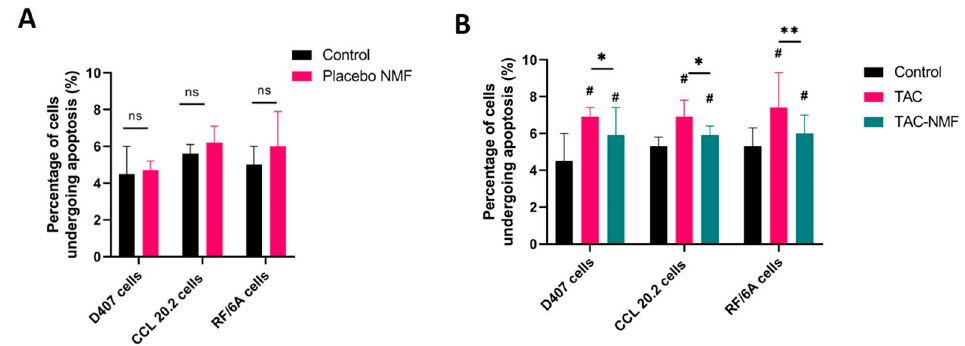
Figure 9. Determination of cell apoptosis in D407, CCL 20.2 and RF / 6A ocular cells after treatment with placebo NMF, TAC and TAC-NMF by Annexin V / FITC and PI-Staining. ( A ) Percentage of cell apoptosis in D407, CCL 20.2 and RF / 6A cells after treatment with placebo NMF for 24 h determined by fluorescence assisted cell sorting (FACS). ( B ) Percentage of cell apoptosis in D407, CCL 20.2 and RF / 6A ocular cells treated with TAC or TAC-NMF for 24 h determined by FACS. Results are expressed as a mean of three independent experiments, n = 3 ± SD. (# p ≤ 0.05 as compared to control, * p ≤ 0.05 between group and ** p ≤ 0.01 between group, ns = not significant difference between groups) .